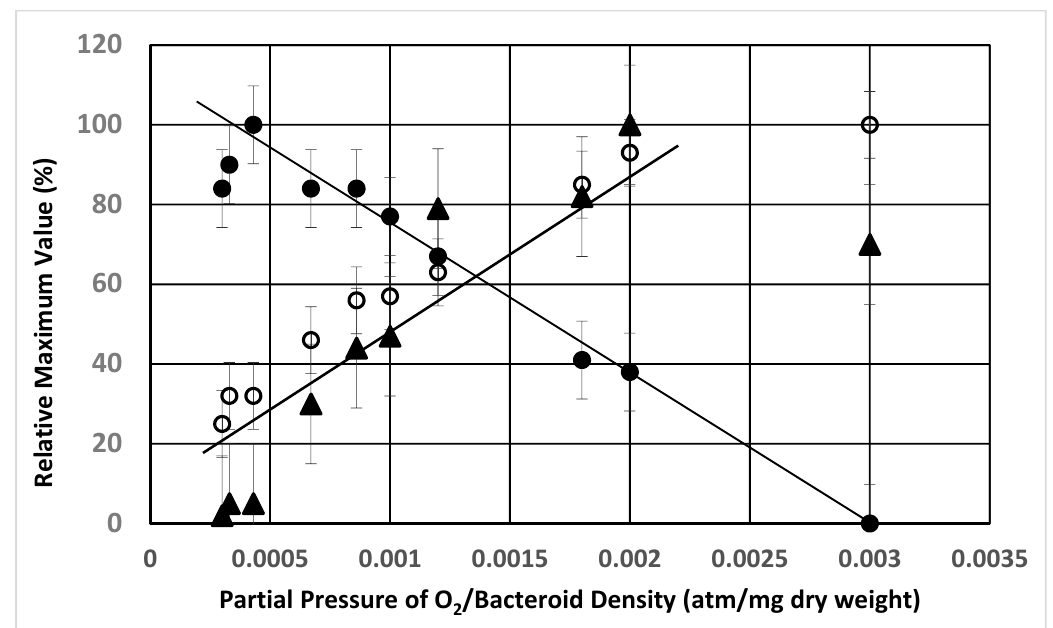
Figure 5. Relative rates of alanine, valine excretion and ammonium uptake from ex planta B. diazoefficiens bacteroids compared by the ratio of partial pressure of oxygen divided by the bacteroid density. The maximum rate of excretion at each partial pressure of oxygen (Figure 4) was divided by bacteroid density for alanine (closed circles), valine (open circles) and ammonium (closed triangles). The maximum rate for each nitrogen compound was set at a value of 100% and all remaining rates for that nitrogen compound were determined as a percent of the maximum rate for each nitrogen compound. All assays performed in the presence of 2 mM L -malate as described in Section 4.